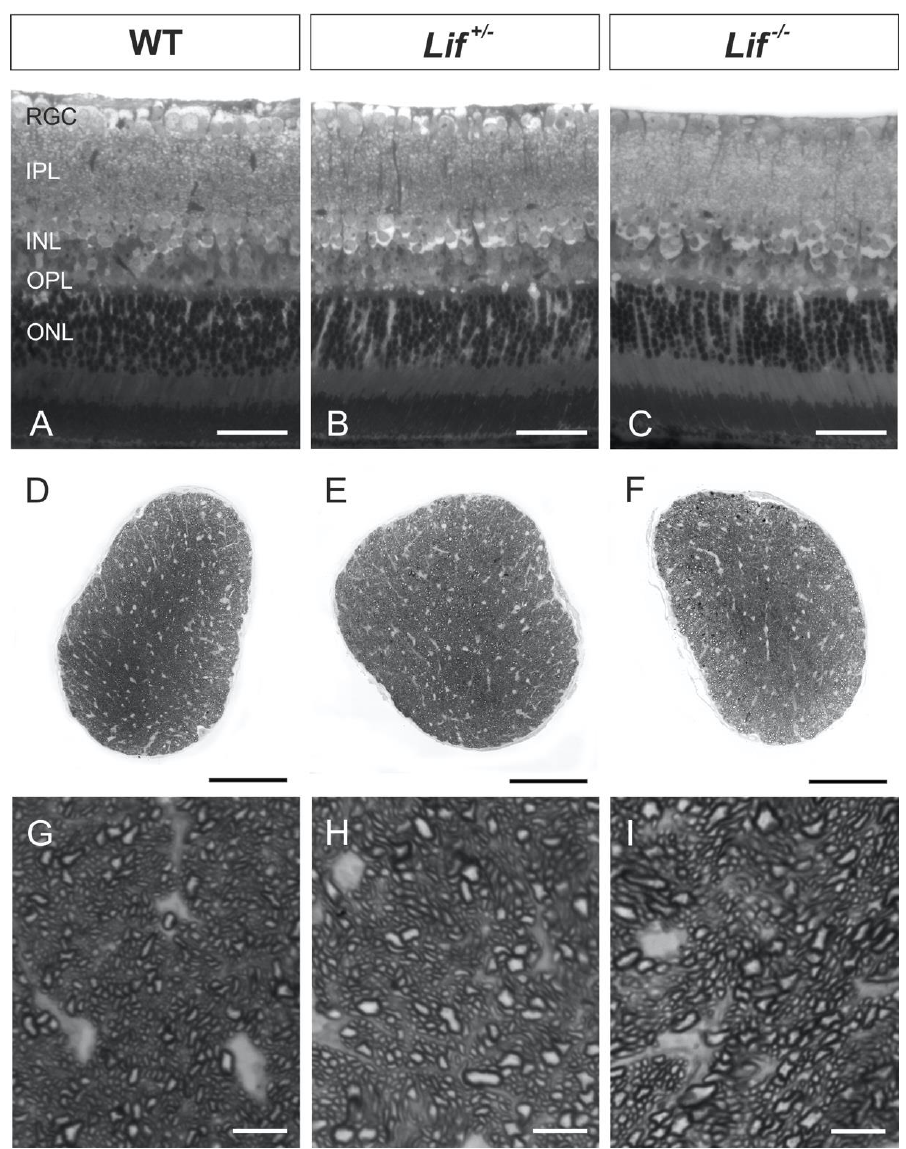
Figure 1. Lif-deficient mice do not show an obvious retinal or optic nerve phenotype.